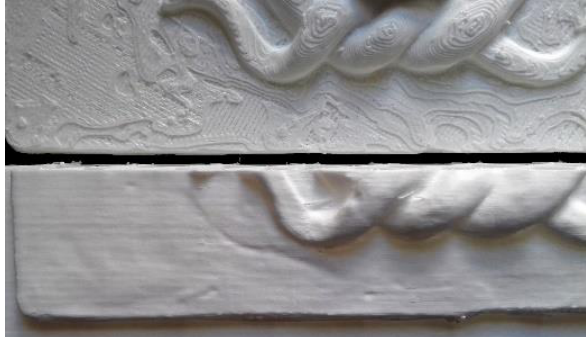
Figure 9. The Medusa mask; up side, horizontal printing; down side, vertical printing